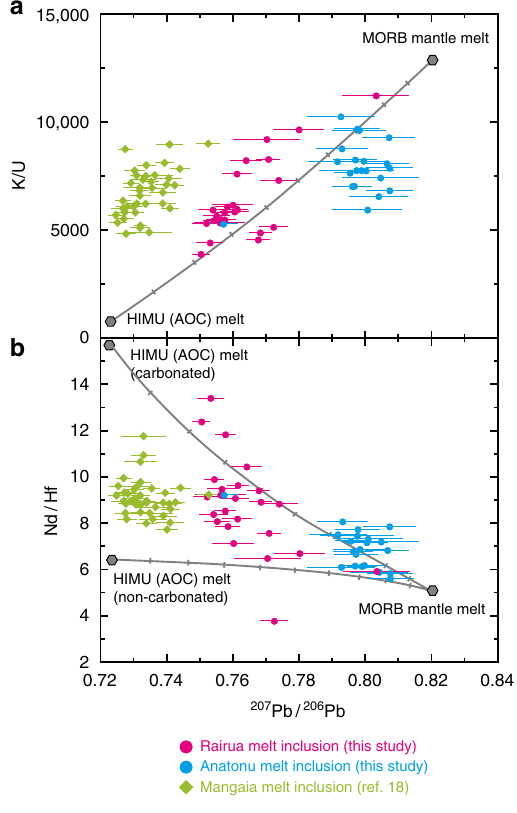
Fig. 2 Melt inclusion Pb isotopes versus lithophile element ratios. a 207 Pb/ 206 Pb versus K/U. b 207 Pb/ 206 Pb versus Nd/Hf. Symbols for melt inclusions are the same as in Fig. 1. Error bars with the 207 Pb/ 206 Pb data of this study are bracketing standards propagated in-run 2 S.E. Mixing lines between melts from the model HIMU source (2 Ga carbonated and non-